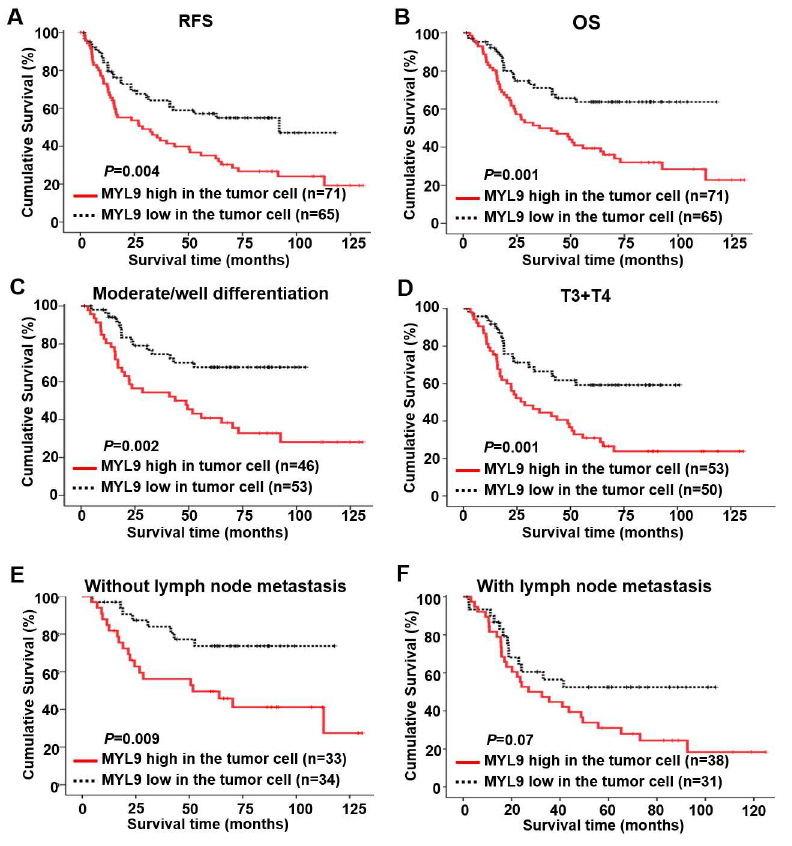
Fig 4. Kaplan–Meier curves of univariate analysis data (log–rank test). (A, B) The RFS (A) and (B) OS of patients with high versus low MYL9 expression. (C) The OS for moderately/well-differentiated patients with high versus low MYL9 expression. (D) The OS for patients with T3+T4 classification with high versus low MYL9 expression. (E, F) The OS for patients without lymph node metastasis (E) and with lymph node metastasis (F) with high versus low MYL9